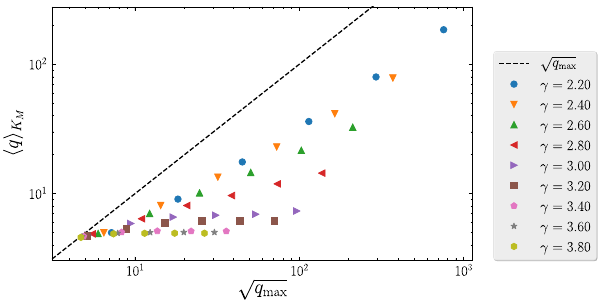
FIG. 12. Average maximum core index h K network size for reshuffled LPA networks with different degree exponent γ . Error bars are smaller than symbol sizes.